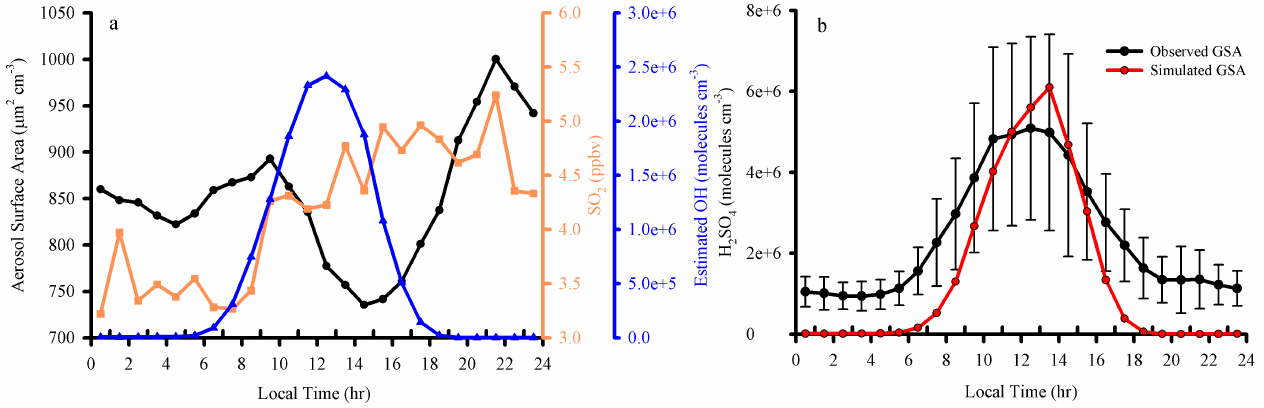
Fig. 4. (a) Hourly average diurnal profiles of aerosol surface area, SO 2 , and modeled OH from 7 July to 25 September; (b) calculated (red) and measured (black) diurnal profiles of